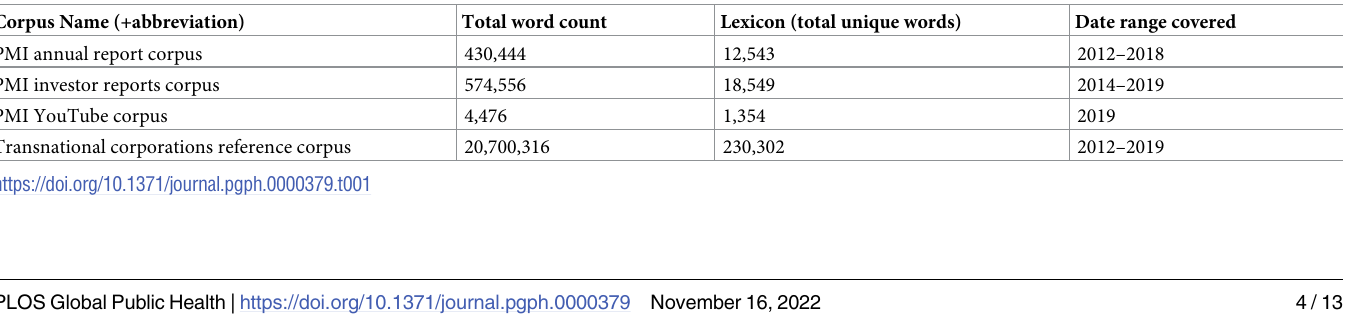
Table 1. Corpora compiled for CL